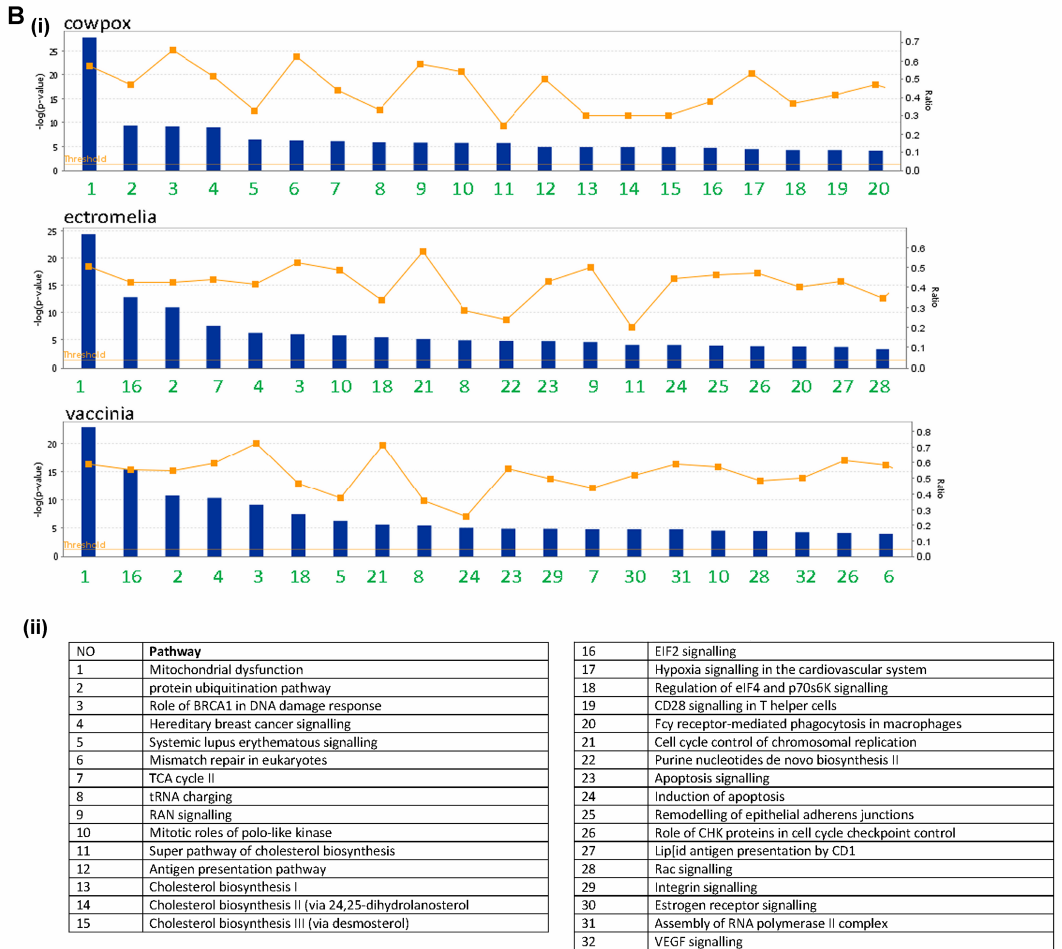
Figure 3. Different canonical pathways in RAW cells infected with cowpox virus (CPXV), ectromelia virus (ECTV) and vaccinia virus (VACV) showing differential gene expression. ( A ) Up-regulated and ( B ) down-regulated gene expression at 16 h post-infection (H). The microarray data set was processed using GeneSpring GX 11.0 and uploaded into Ingenuity Pathway Analysis version 2012 (IPA). The data was filtered based on the significance fold change (FC) cut-off ≤ to 0.05 and FC cut-off ≥ 2. Genes were categorized using IPA, and p -values were calculated by Fisher’s exact test for each canonical pathway. Threshold was set at p -value = 0.05 and indicated as –log ( p -value) on the y-axis. (i) The top 20 statistically significant canonical pathways were identified for each infection time point and indicated by numbers on the X-axis. (ii) Table showing the numbers representing each pathways. The lines with orange boxes represent the ratio of the numbers of genes that show changes in gene expression data and the total number of genes in the respective canonical